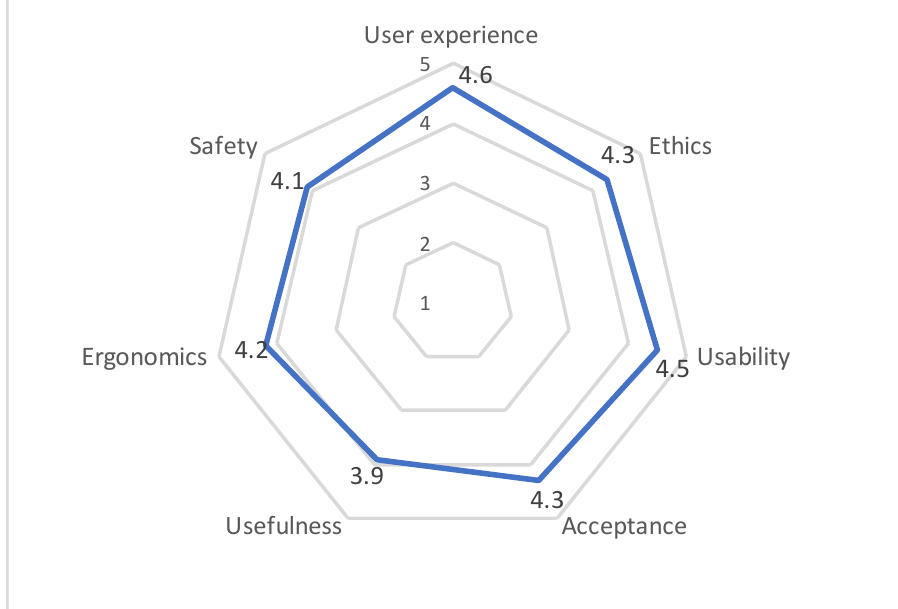
Figure 10. Results of the human factors questionnaire for the Siemens use case.